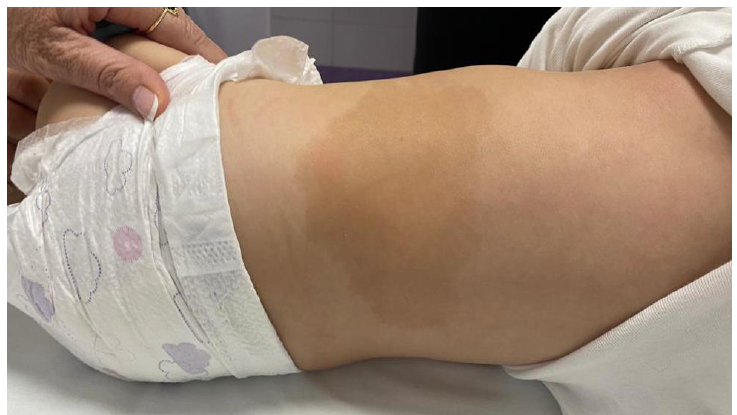
Figure 1. Cafe au lait macule.